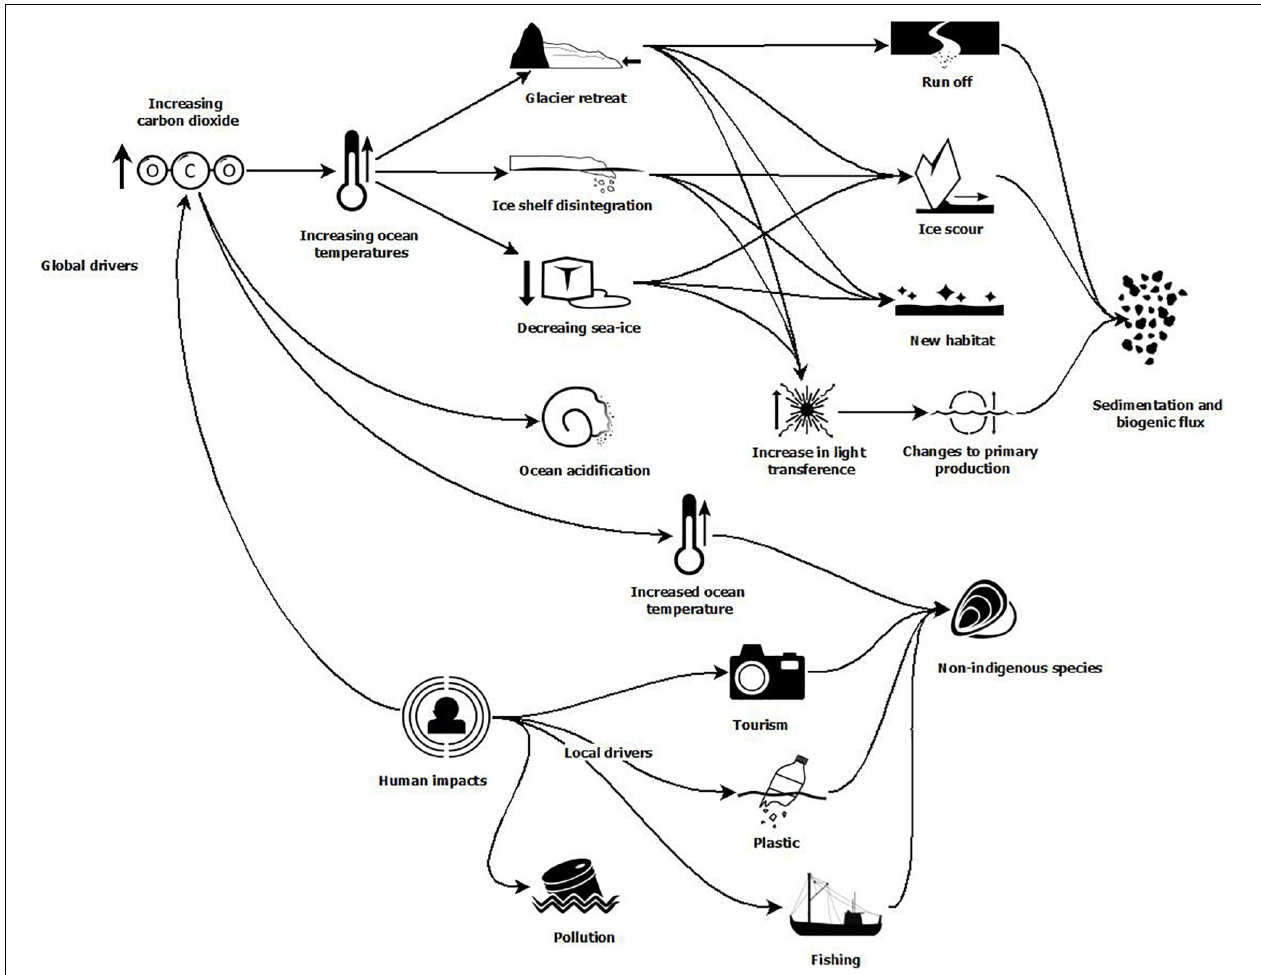
FIGURE 1 | Example pathways for impact drivers of change in the Southern Ocean that can affect benthic communities. See Morley et al. (2020) and Grant et al. (to be published in this research topic) for more details regarding global and local impact drivers within the MEASO